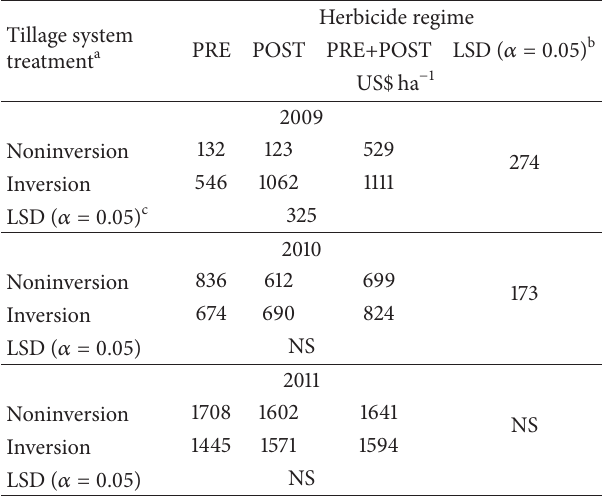
Table 7: Influence of tillage system by herbicide interaction on net returns (US$ ha −1 ) by